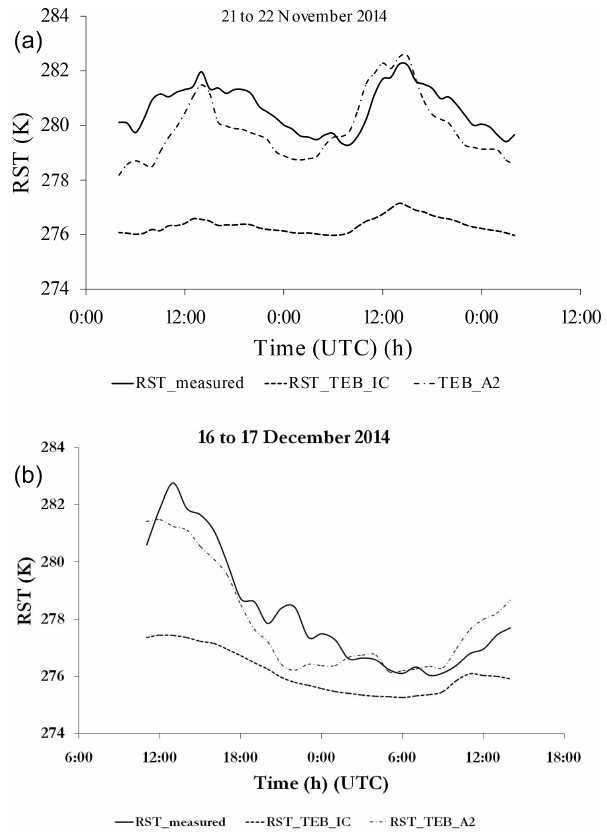
Figure 9. Comparison between RST from TEB in its initial configuration (RST_TEB_IC), RST from TEB via the first ap- proach (RST_TEB_A1), RST from TEB via the second approach (RST_TEB_A2) and field data (RST_measured) for the first (a) and for the second (b) experiments.